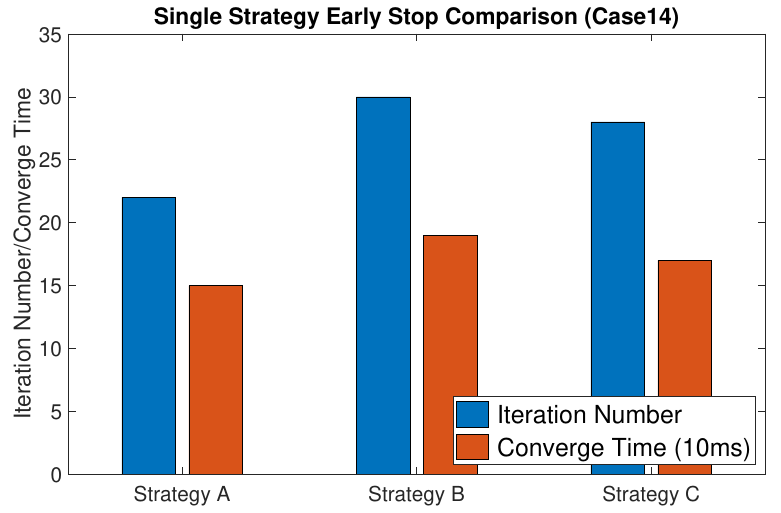
Figure 4. Single strategy early stop comparison. Using only one strategy till converge with constraint violation tolerance set to 5 × 10 − 3 . The blue bar is the number of iterations for each strategy, and the red bar is the convergence time in 10